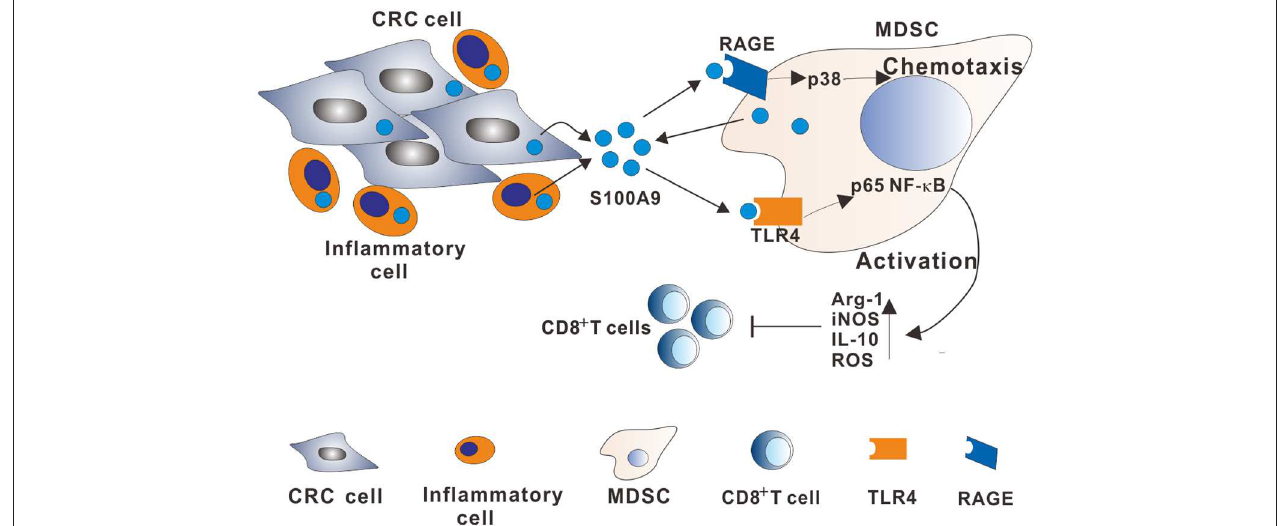
FIGURE 8 | A model describing the mechanisms of the S100A9-induced immunosuppressive microenvironment by regulating MDSCs chemotaxis and activation in CRC. Increased extracellular S100A9 protein derived from CRC cells, inflammatory cells, or MDSCs in TME stimulates RAGE-dependent p38 MAPK signaling cascade, promoting MDSCs chemotaxis. Additionally, increased extracellular S100A9 in TME stimulates the TLR4-dependent NF- κ B signaling cascade, promoting MDSCs activation by upregulating immunosuppressive molecules Arg-1, iNOS, and IL10 expression, and ROS